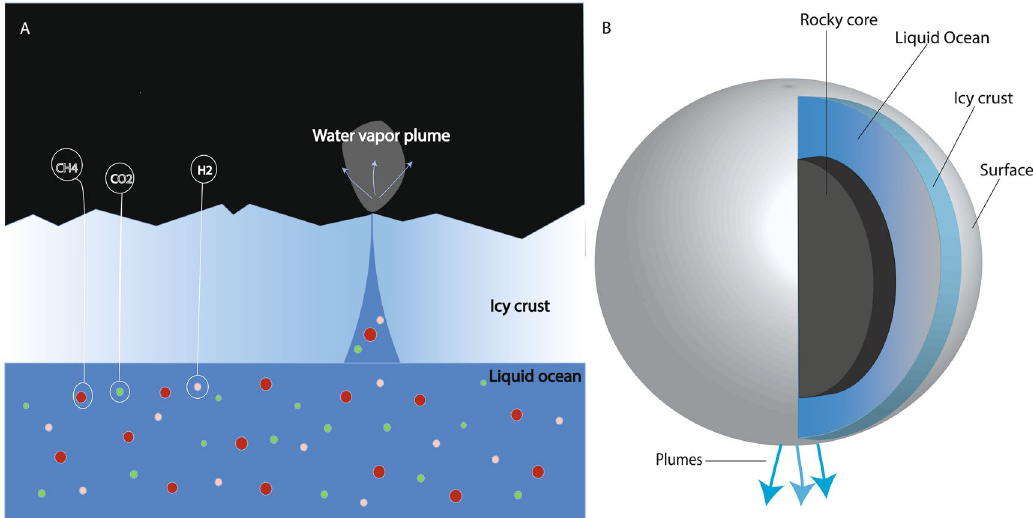
Figure 2. ( A ) View of a cross section of Enceladus and the ocean of Enceladus. ( A ) Enceladus ocean and icy crust. ( B ) Cross section of Enceladus’s icy crust, ocean and core. Image credit: illustration by N. Y. Wagner, drawing upon schematic renderings from NASA/JPL-Caltech and the Southwest Research Institute.